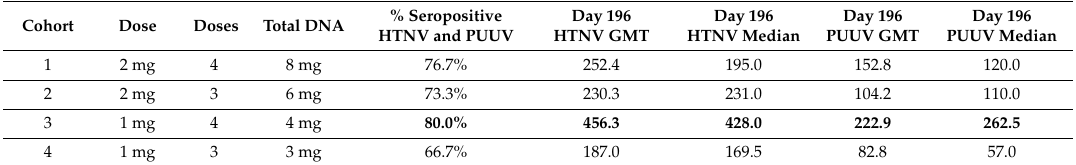
Table 5. Dose vs. neutralizing antibody response